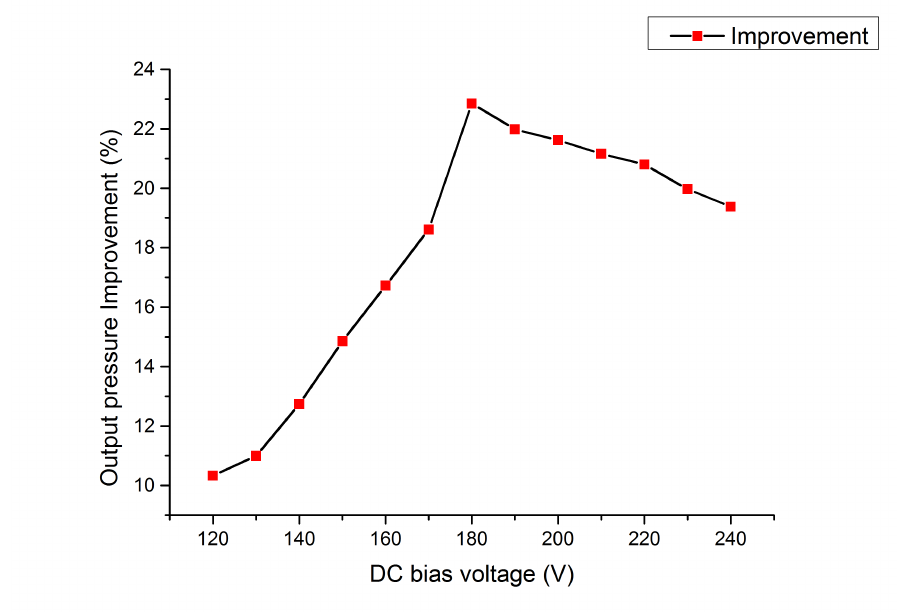
Figure 3. Output pressure improvement of the embossed CMUT cell in FEA